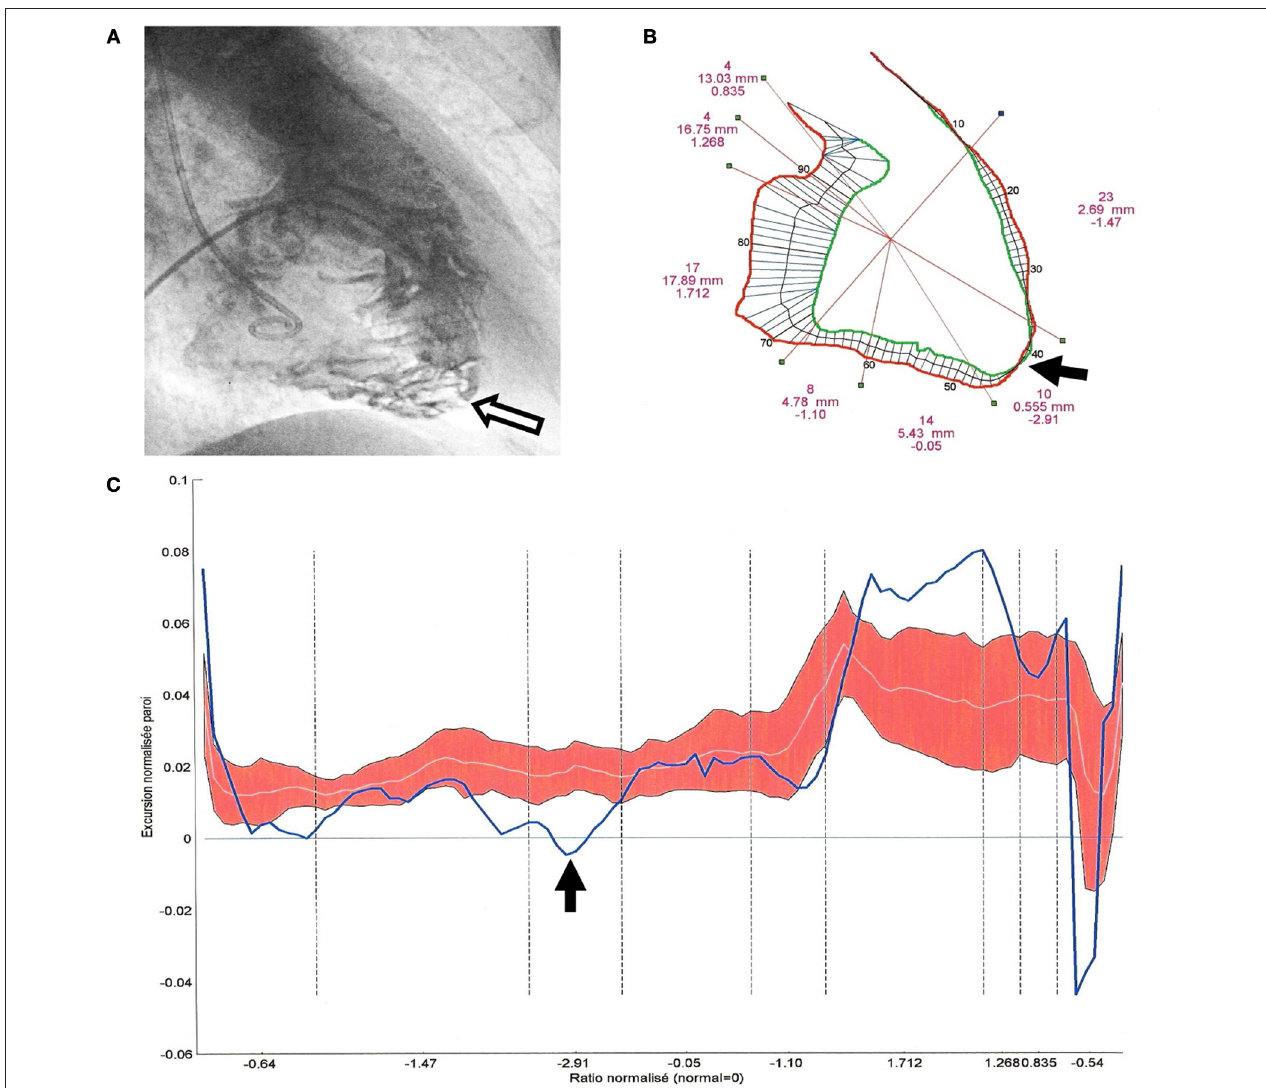
dyskinetic apex (black arrow), a normal inferior contraction and a hypokinetic sub-tricuspid segment. TAPSE, RV volumes, and RVEF were normal. (C) Segmental excursions are plotted (blue line, bold) on a nomogram in a clockwise direction from the high RVOT to the TAPSE and the crista supraventricularis. Normal excursion values are represented by the red zone (the white line represents the mean values of control patients and the red zone corresponds to + 1 SD or − 1